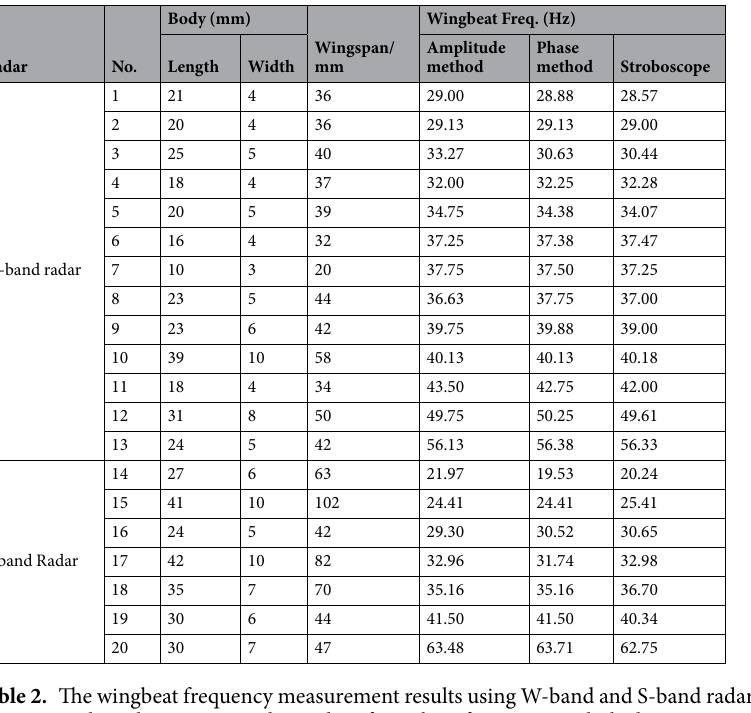
Next, we performed a statistical analysis of the wingbeat frequency measurements of the W-band and S-band radars (see Table 3). For the amplitude-based method, the standard deviation (SD) is 0.89 Hz for the W-band radar and 1.29 Hz for the S-band radar, while for the phase-based method, the SD is 0.33 Hz for the W-band radar and 1.06 Hz for the S-band radar. It can be found that the signal phase shows a higher precision in the wingbeat frequency measurement than the signal amplitude, although the precision difference is not quite signif- icant especially in the S-band. These results prove that the micro-Doppler phase variation is consistent with the insect wing-beating, and it could indeed be used to measure the wingbeat frequency. In addition, the statistical